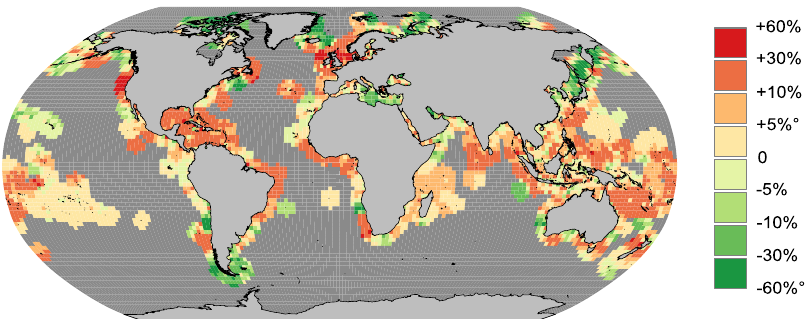
Fig. 4 | Functionalvulnerabilityofglobalreef fi shcommunitiesand associated trends over the coming 60 years. a Projected functional vulnerability ([2041- 2070]) of coastal fi sh communities under the SSP1-2.6 scenario. b Relationship between species richness and functional vulnerability for the period 2041 –